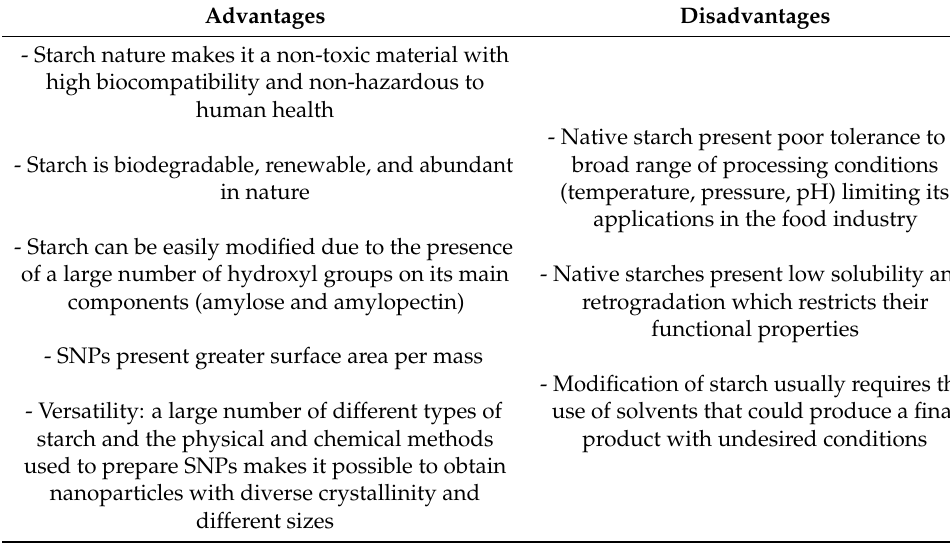
Table 1. Advantages and disadvantages of SNPs versus other types of